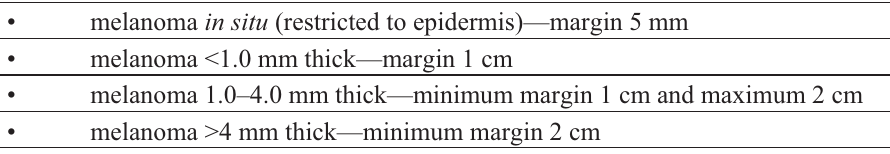
Table 5. Guidelines for excision margins for melanoma